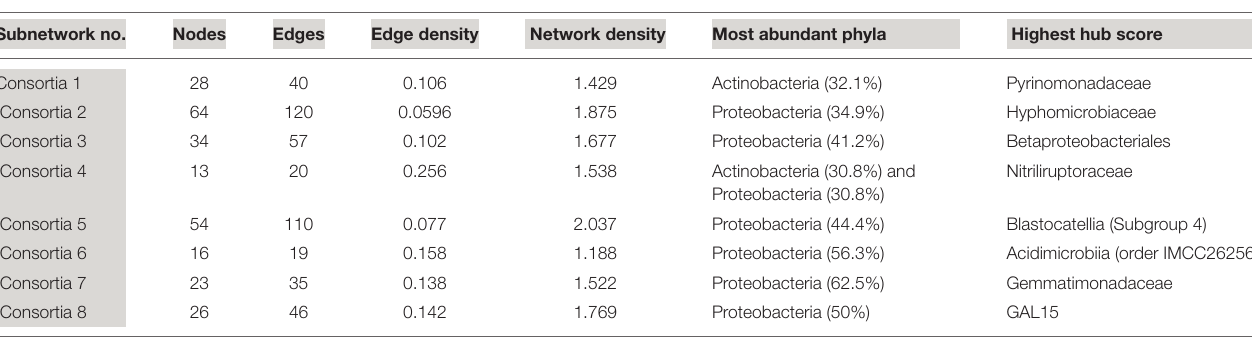
TABLE 3 | Subnetwork statistics and information for lava tubes. Subnetwork